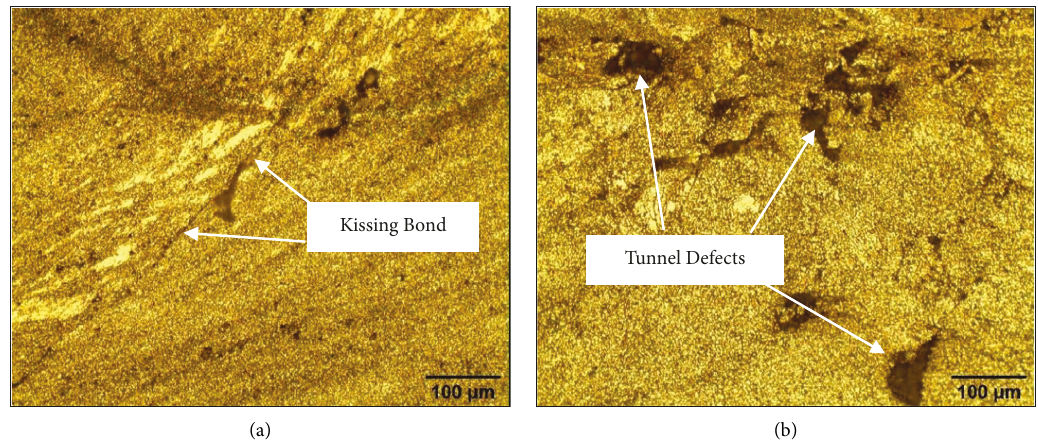
Figure 6: Microstructure of the defects for SS-FSW: (a) 146mm/min and (b) 216